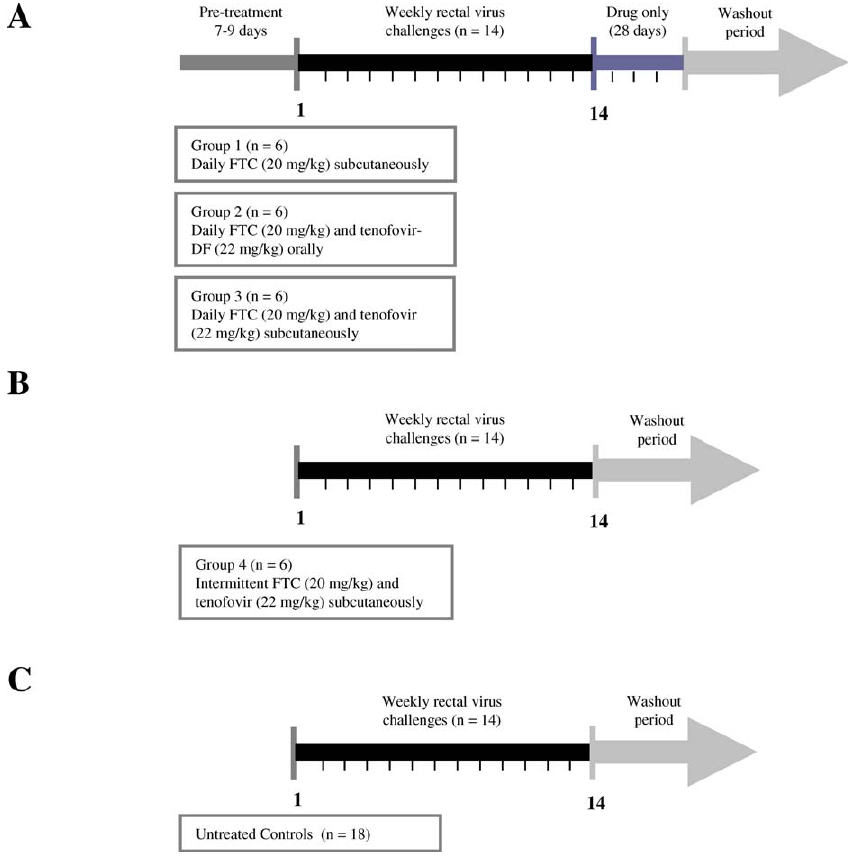
Figure 1. Study Design and Interventions (A) Daily PrEP. Macaques were drug-treated 7–9 d before the first virus inoculation. Treated animals that remained negative during the 14 challenges received drug for an additional 28 d. Treated animals that became infected continued treatment to monitor plasma viremia and drug